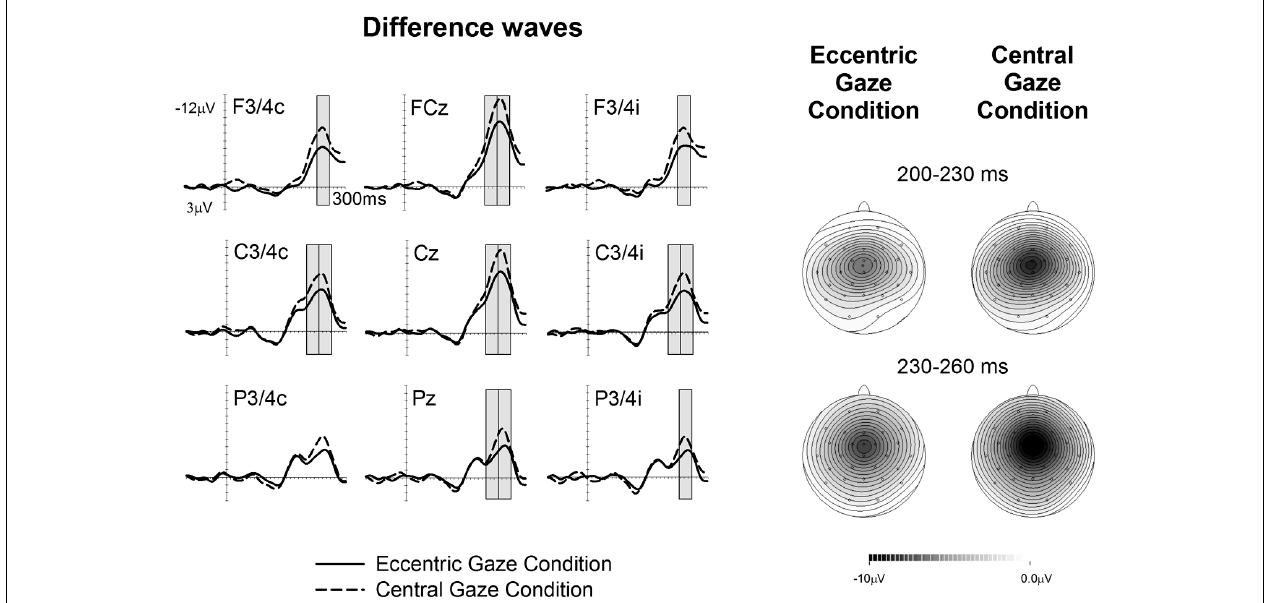
Eccentric and Central gaze conditions.The corresponding topographical voltage maps of attention effects for tactile ERPs are shown separately for the Eccentric gaze and Central gaze conditions for the 200–230 ms, and 230–260 ms intervals after stimulus onset, and are computed by spherical spline interpolation. Amplitude scales range between –10 and 0 μ V for the Eccentric gaze condition and –10 to 0 μ V for the Central gaze condition.